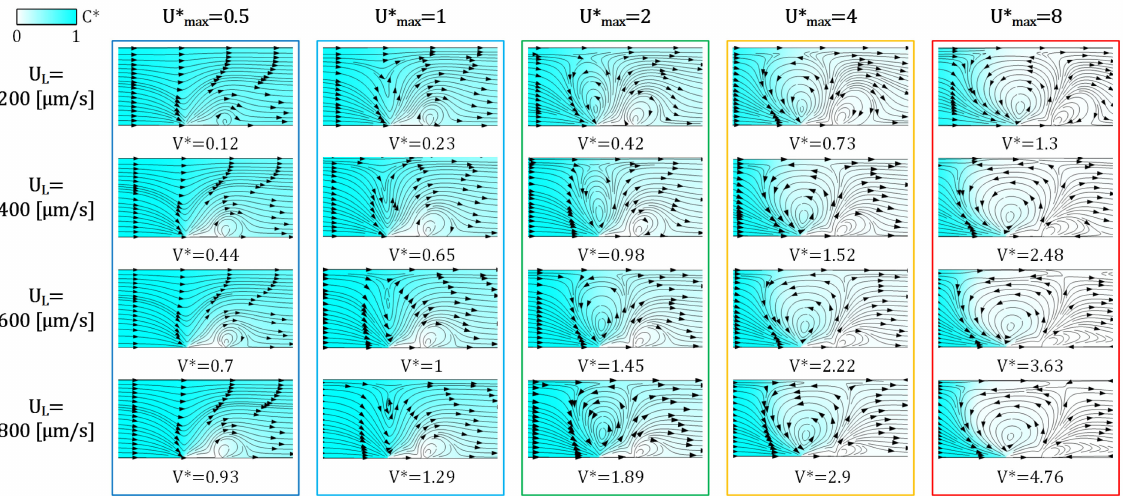
Figure 4. The influence of U L and V ∗ is categorized by U ∗ max for measuring the vortex size and ICP performance. Arrows demonstrate the fluid flow direction. The critical point, U ∗ max = 1, is where the main ICP vortex is produced from the central stagnation point for the first time. By increasing U ∗ max , another stagnation point forms over the vortex, and an IDZ